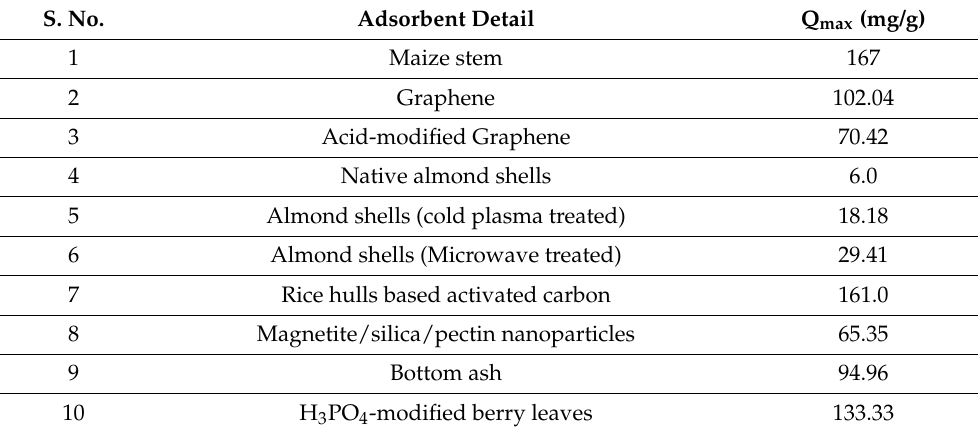
Table 6. Comparative study of Eriochrome Black T adsorbed on different adsorbents [16,28,41]. S.